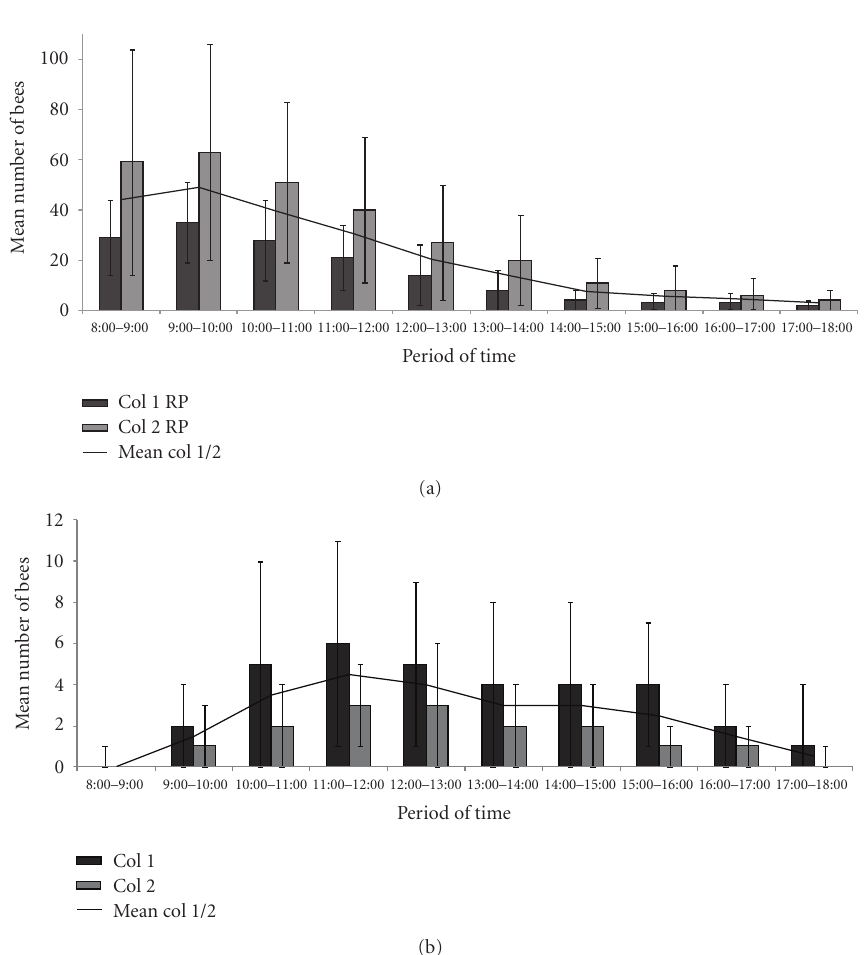
Figure 4: Pollen collection patterns of two colonies of Plebeia remota in the reproductive phase (a) and in the diapause (b).